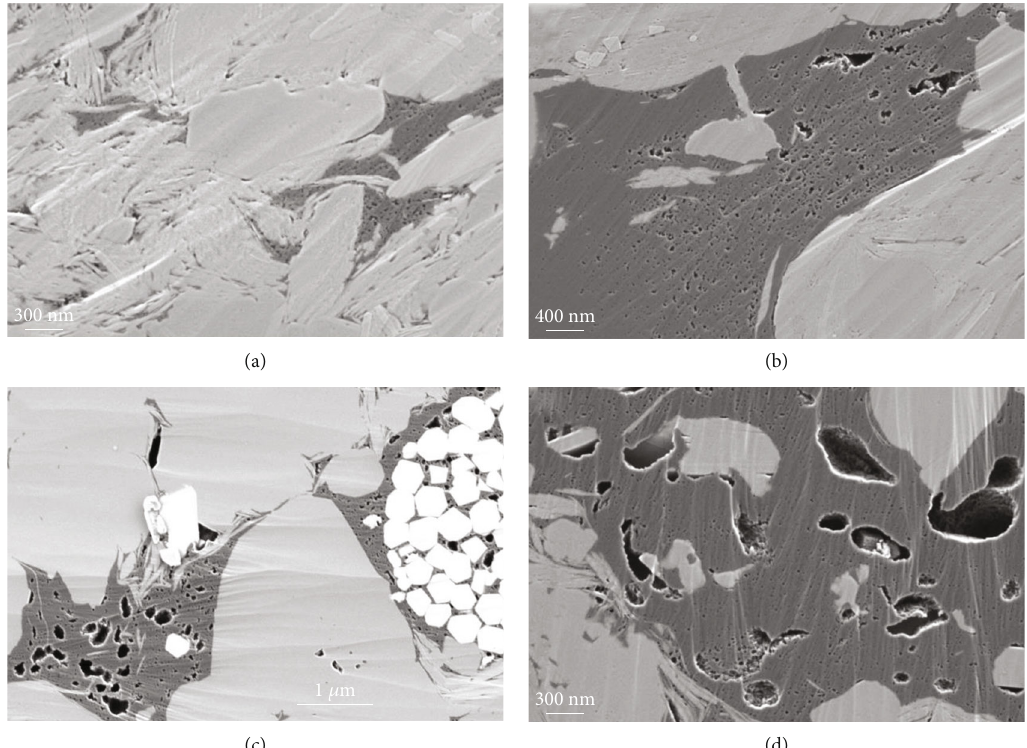
Figure 7: Pore structure of gas shales using FE-SEM technology: (a) sample JY41; (b) sample JY71; (c) sample JY101; (d) sample